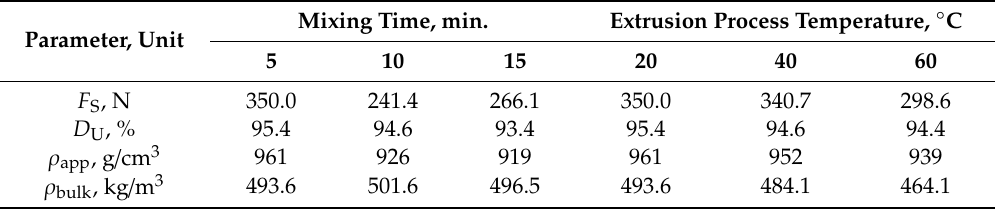
Table 4. Properties of briquettes produced (variable: mixing time and extrusion process temperature). Parameter,